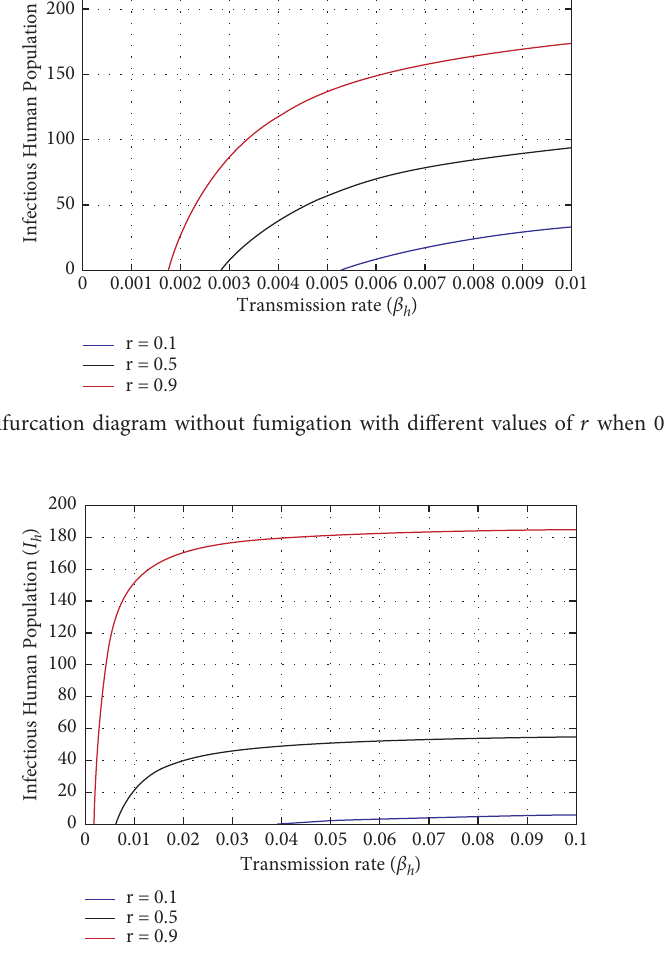
Figure 16: Bifurcation diagram without fumigation with different values of r when k � 1.